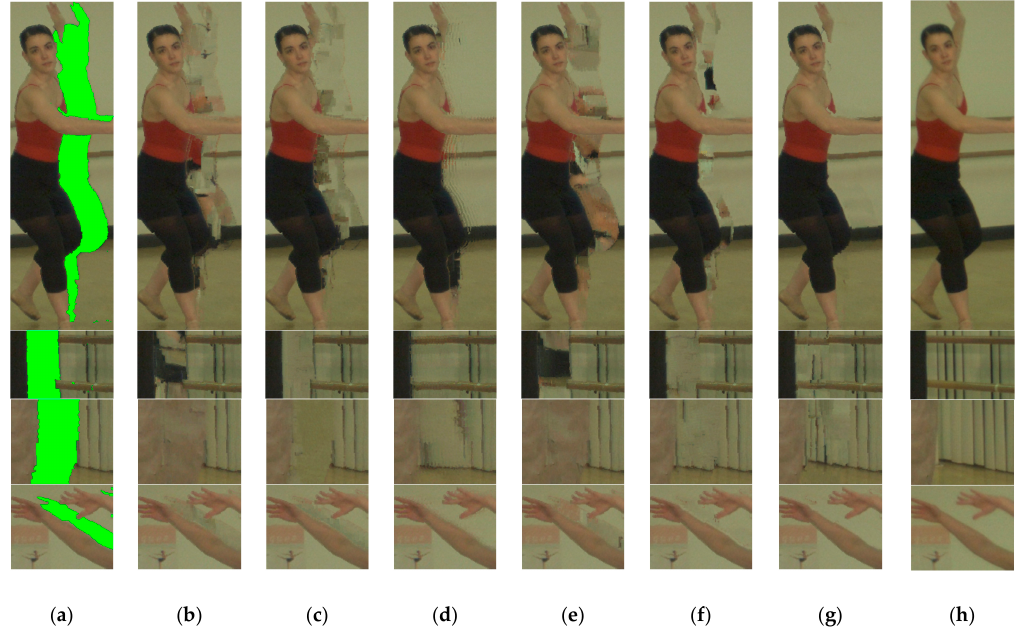
Figure 11. Disocclusion filling results in the case of small baseline: ( a ) Disocclusions after DIBR; ( b ) Criminisi’s method; ( c ) Daribo’s method; ( d ) Lei’s method; ( e ) Oliveira’s method; ( f ) Kao’s method; ( g ) the proposed method; and ( h ) ground truth.